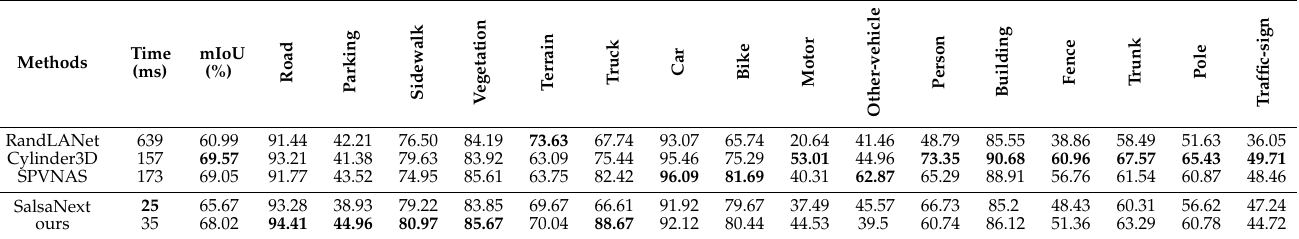
Table 1. Comparisons with state-of-the-art methods on the SemanticKITTI